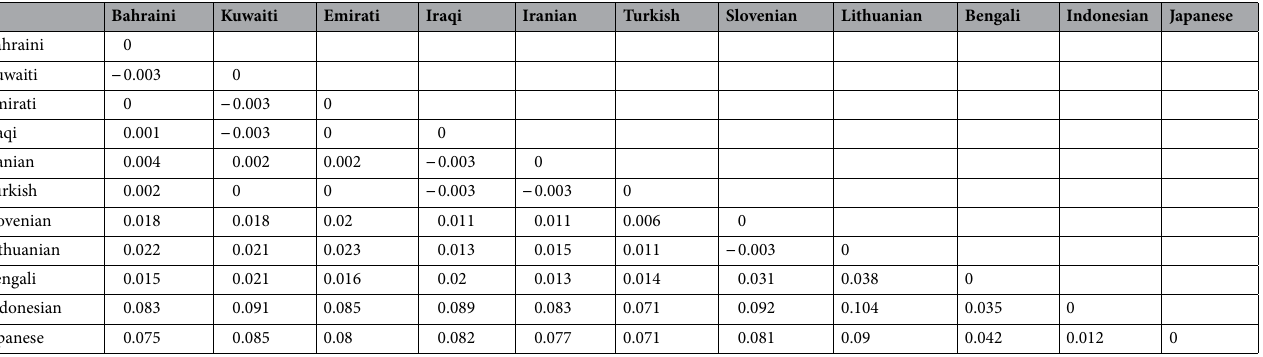
Table 2. Nei genetic distance matrix between Bahraini population and other populations showing the Fst